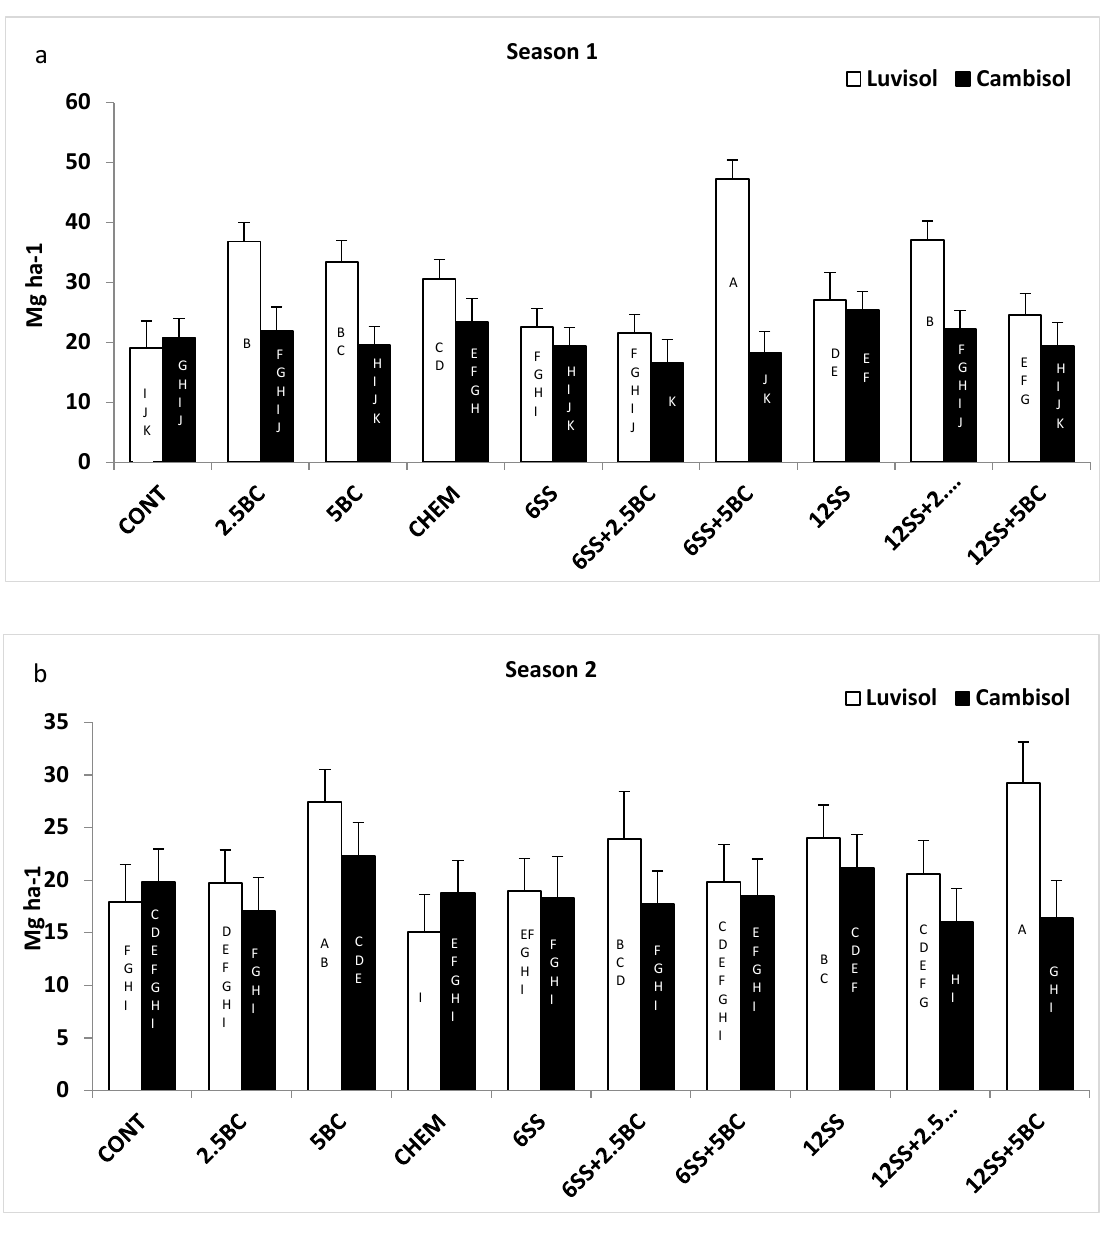
Fig. 4 Spinach yields during two seasons; Season 1 (March – June) and Season 2 (July – Oct) 2018 Error bars denote standard error of the mean (SEM). Columns with different letters are significantly different (p <